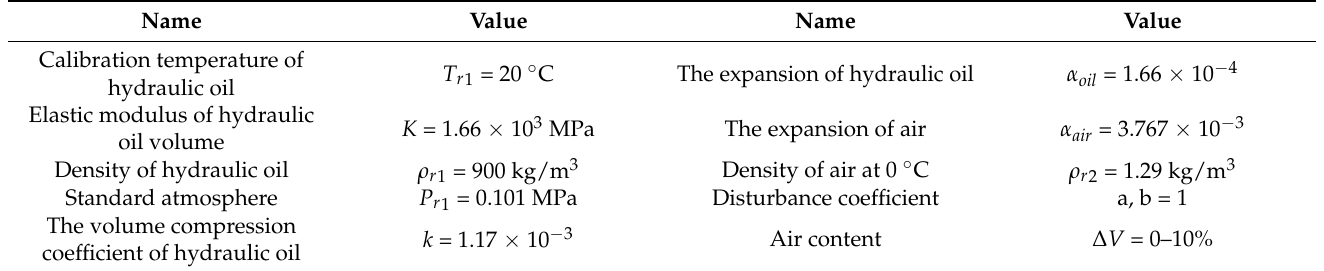
Table 1. The working medium characteristic parameters and disturbance coefficient.